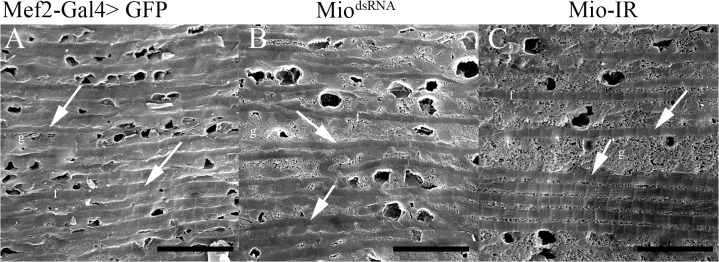
Decreasing Mio levels results in abnormal myofibril organization.Scanning Electron Microscopy of longitudinal sections of Indirect Flight Muscles of adult Mef2-Gal4>MiodsRNA and Mef2-Gal4>Mio-IR females compared to Mef2-Gal4>GFP controls. f, myofibril; g, glycogen granules. Each arrow points to a single longitudinal myofibril. Scale bar = 20μm.